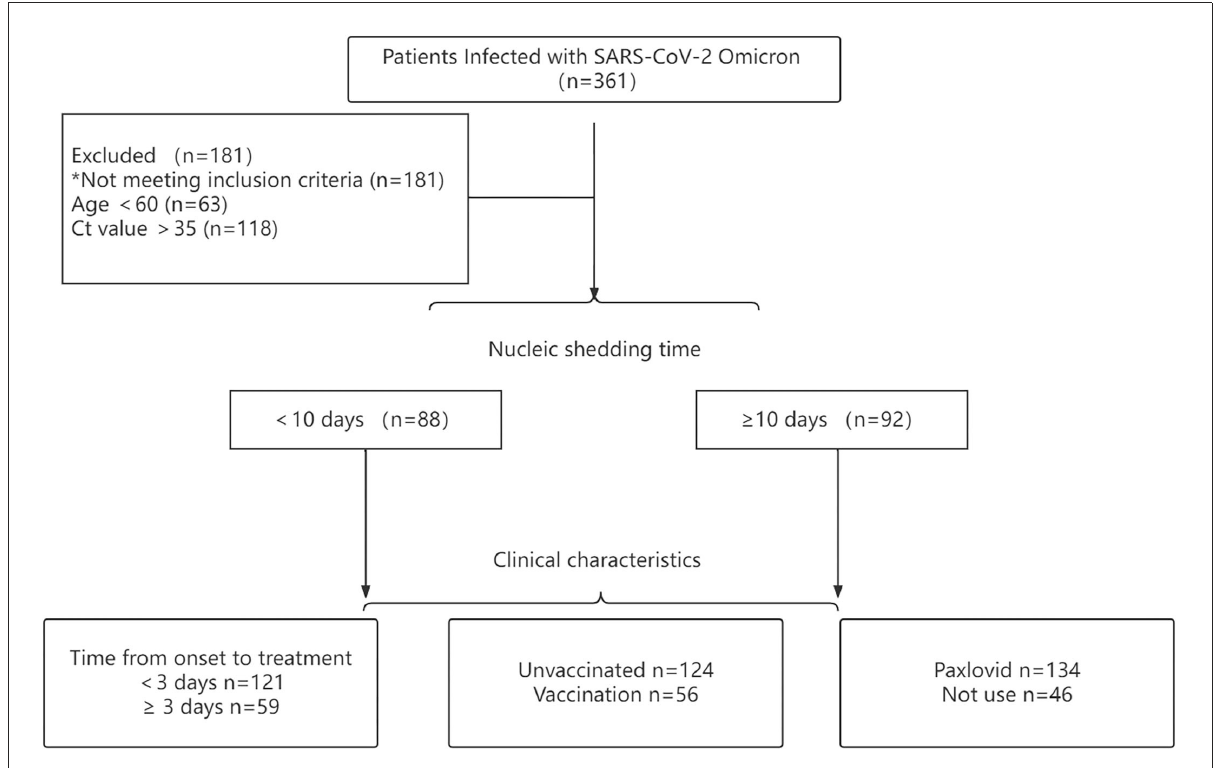
FIGURE1 Flow diagram of patients with confirmed SARS-CoV-2 omicron variant included in this